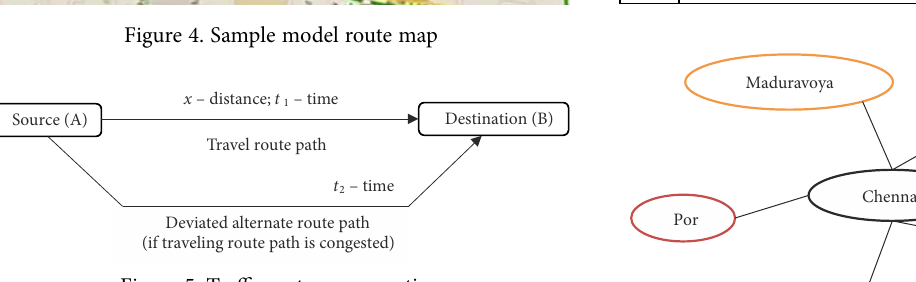
Figure 5. Traffic system assumption